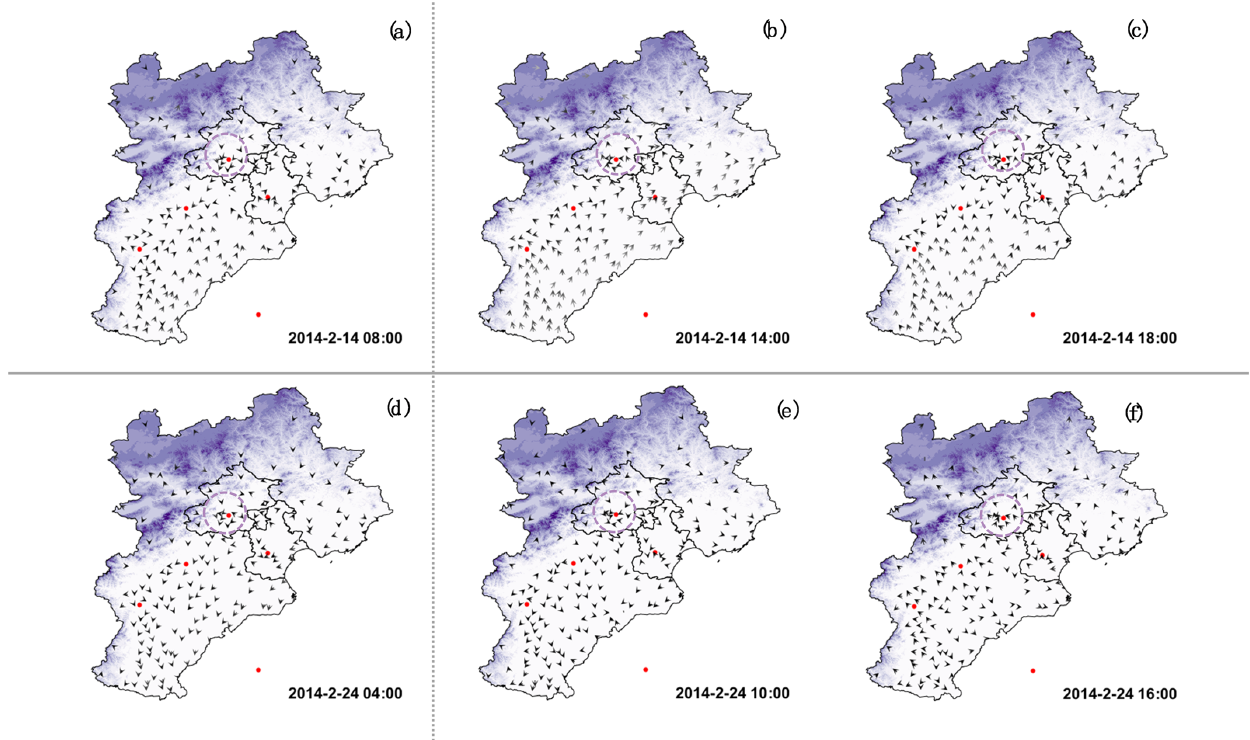
Figure 6. Surface wind distributions before (a, d) and during (b, c; d, e) two convergent explosive growth processes in February 2014 on the North China